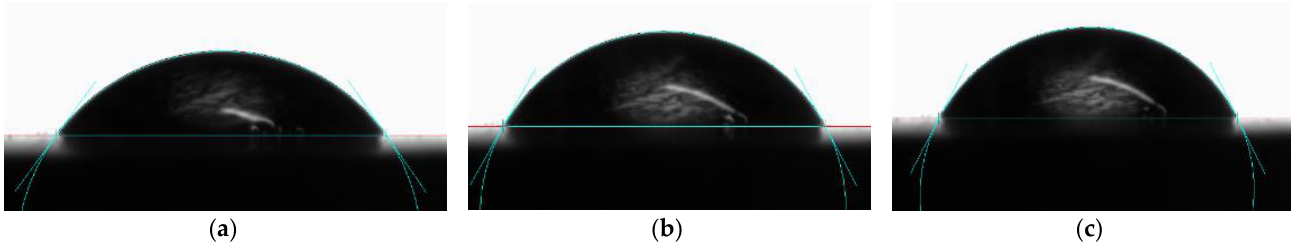
Figure 7. The image of water drops, captured during the contact angle Ɵ W measurements after 5 s from the deposition beginning for the coatings containing: ( a ) no fillers; ( b ) 5 wt.% Sialon; and ( c ) 5 wt.% Alu C.